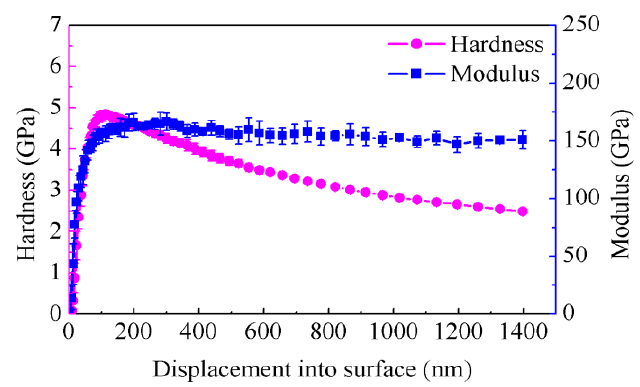
Figure 10. Surface hardness and modulus of the C17200 copper alloy, with increasing displacement measured by nanoindentation.